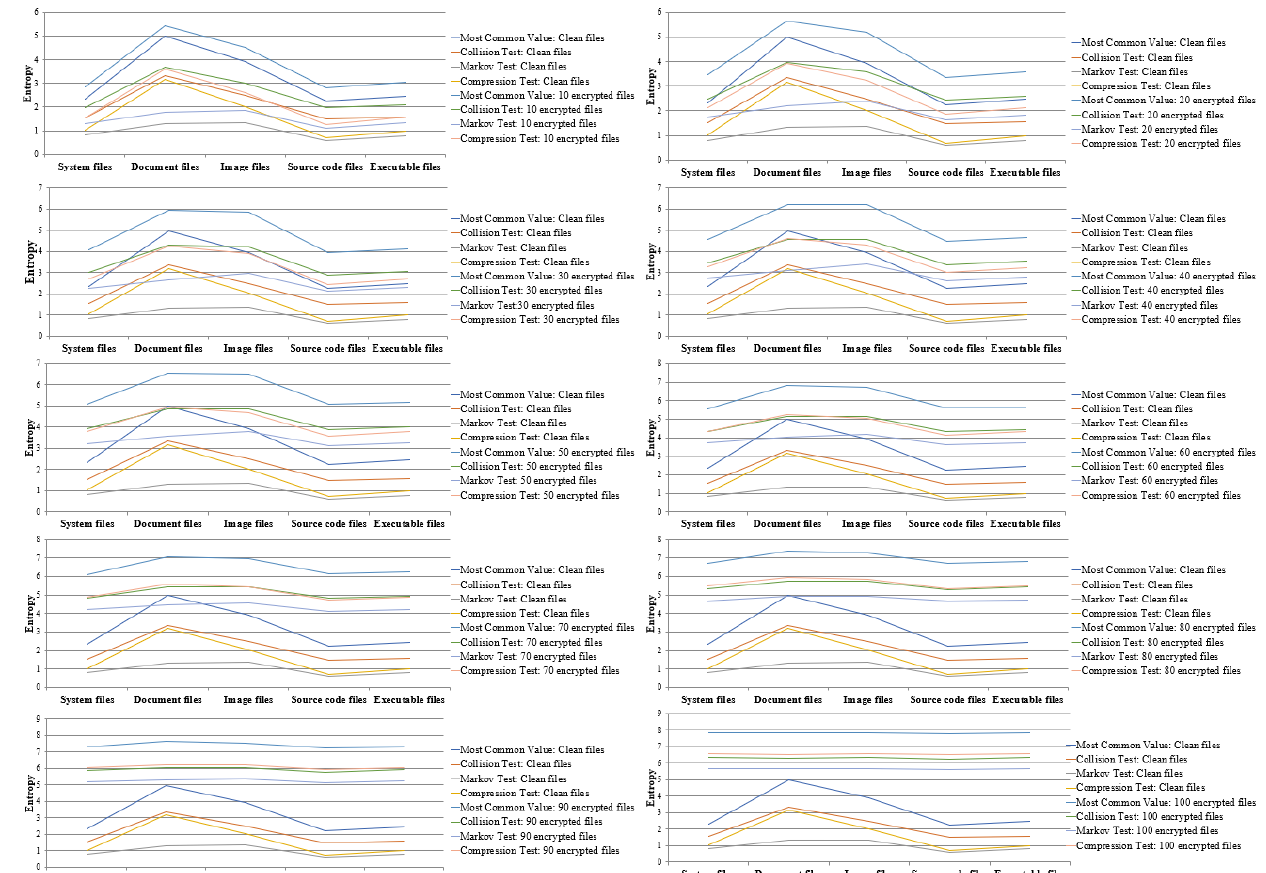
Figure 6. Results of the entropy estimate per 10 ransomware-infected files.